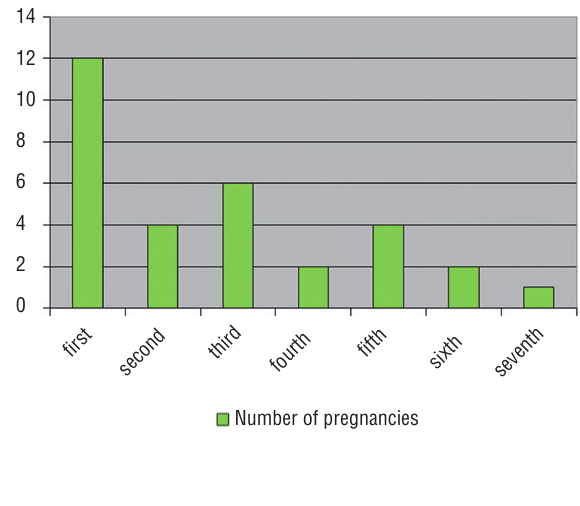
Figure 1 - Postoperative pregnancies stratified by